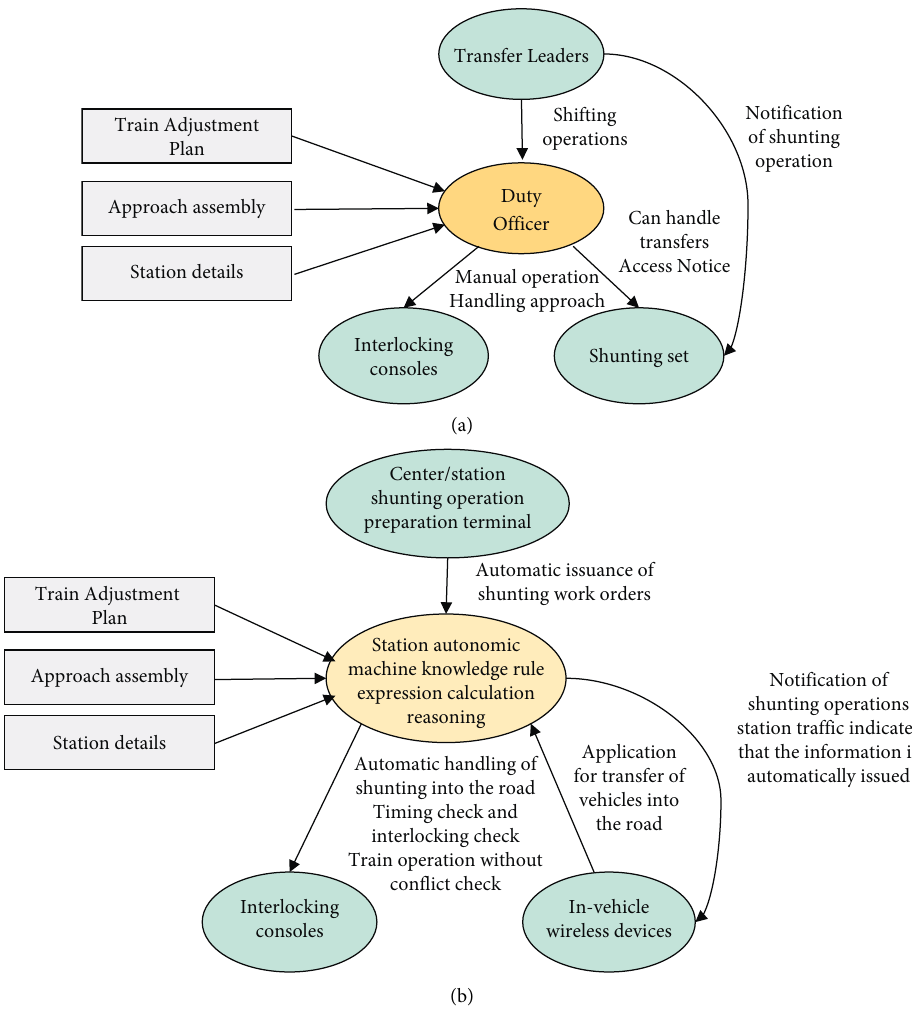
Figure 2: Main workflow of railroad shunting